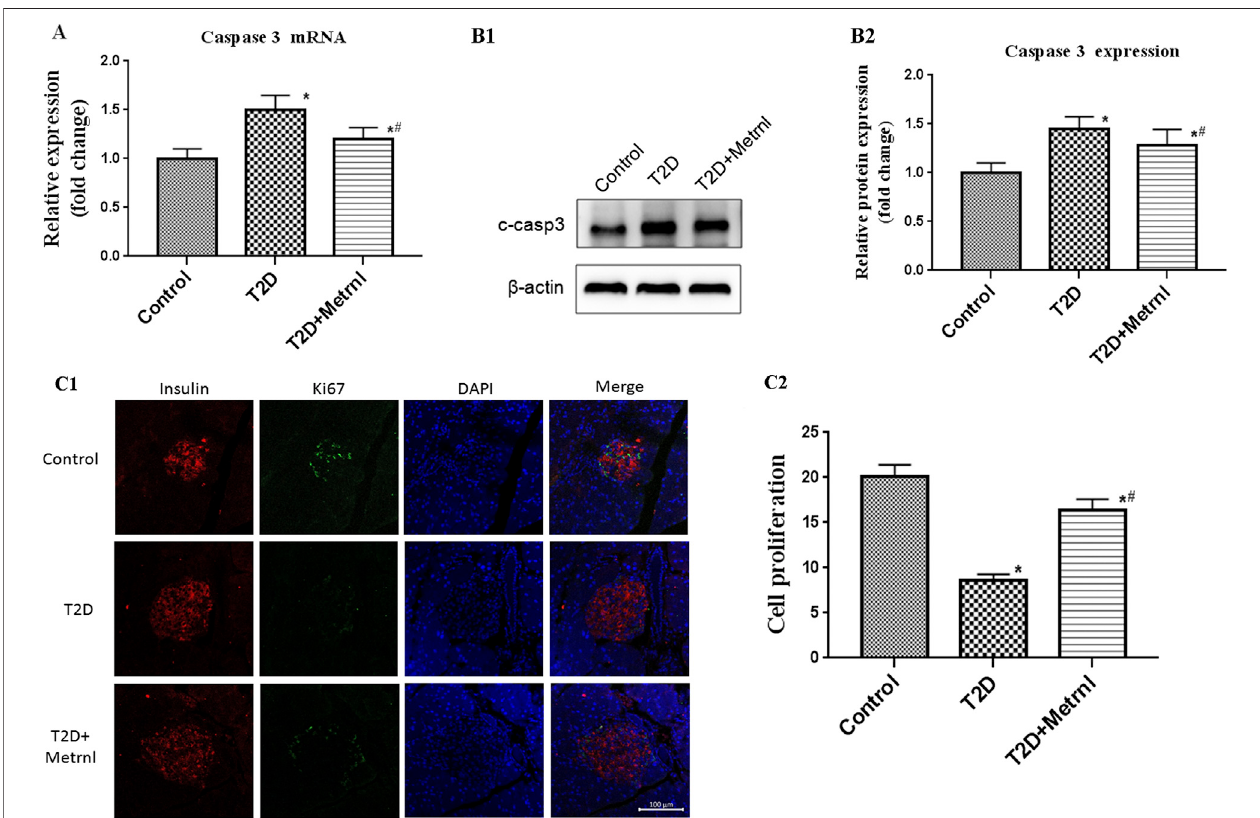
FIGURE 8 | (A) The gene expression of caspase 3 was quanti fi ed by real-time PCR. Data are presented as the fold change of transcripts for the target gene in the indicatedgroupsnormalizedto β -actin.Alldataareexpressedasmean ± SEM[ n (cid:2) 8/group(mRNA)]. (B) Representativewesternblotshowingcaspase3proteinlevelsin the pancreatic tissue of mice. Band densities were converted to a bar graph. All data are expressed as mean ± SEM [ n (cid:2) 8/group (protein)]. (C) β cell proliferation in the pancreatictissue ofmice evaluatedusing Ki67and insulinstaining. Alldata areexpressed asmean ± SEM( n (cid:2) 8/group).* p < 0.05 fordifferencesvs.controlgroup; # p < 0.05 for differences vs. T2D group. T2D: type 2